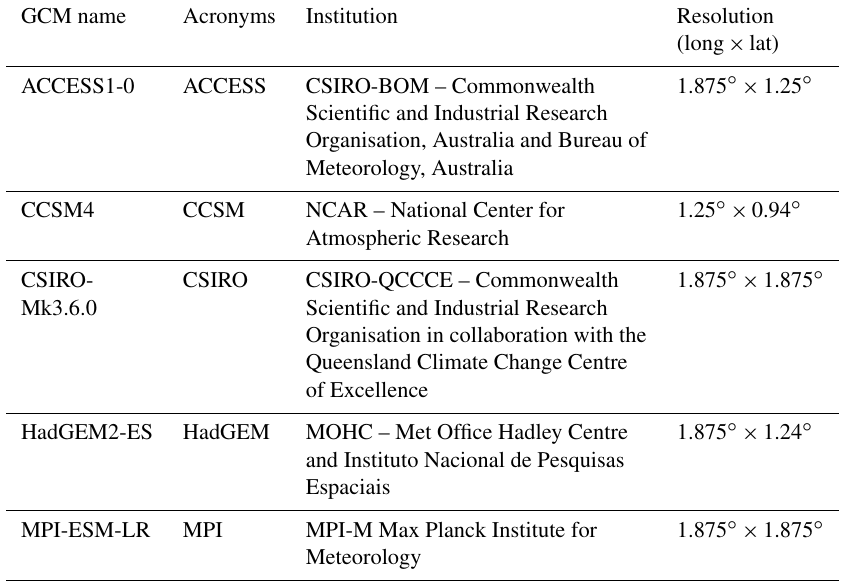
Table 1. Selected CMIP5 GCMs for climatic and hydrological change